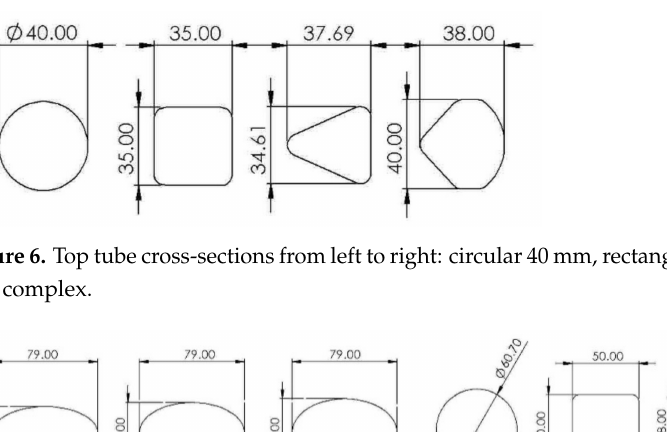
Figure 5. Tested loading scenarios: ( a ) horizontal forces scenario with fixed constraints on the rear ends of the stays, simple support on the bottom end of the head tube, and forces on either end of the head tube; ( b ) static start-up scenario with fixed constraints on the rear ends of the stays and either end of the head tube, and loads on either end of the bottom bracket shell; ( c ) riding scenario with fixed constraints on the ends of stays, simple support on the bottom end of the head tube, and forces on the top of the seat tube, either end of the handlebar and the crankset; ( d ) out-of-plane load to head tube scenario with fixed constraints on the ends of the stays, top of seat tube, and bottom bracket shell; ( e ) out-of-plane load to bottom bracket shell scenario with fixed constraints on the ends of the stays and head tube.